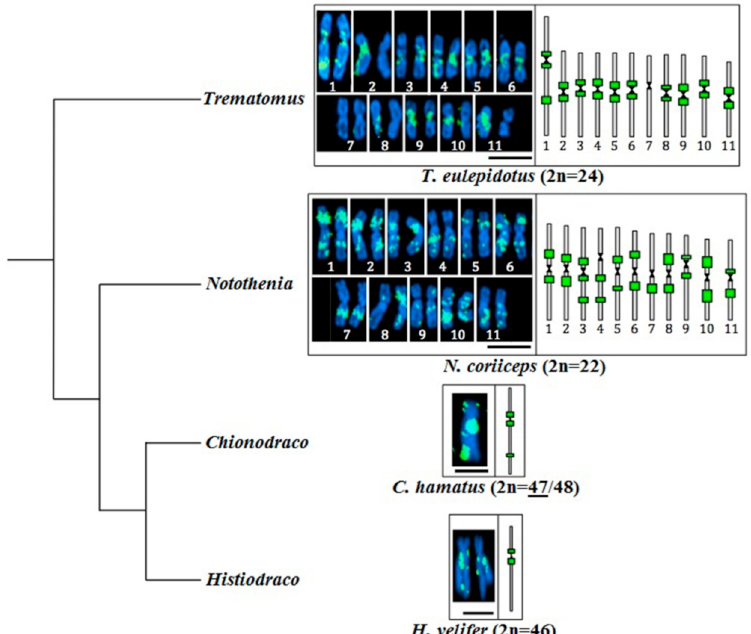
Figure 4. FISH patterns of YNoto on fused chromosomes of T. eulepidotus , N. coriiceps , C. hamatus , and H. velifer . The chromosomal number of C. hamatus is sex dependent. The number for the sex represented in the figure (male) is underlined. Diploid sets for DAPI captures and haploid sets for scheme representations are presented. The main YNoto insertion hot spots observed by FISH are represented by the green rectangles. Scale bars: 7 µ